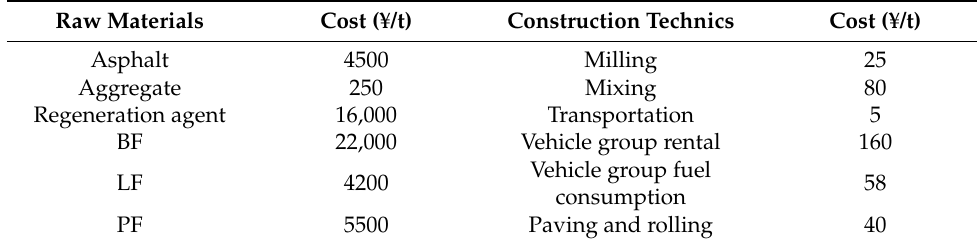
Table 13. Price list of each maintenance process.